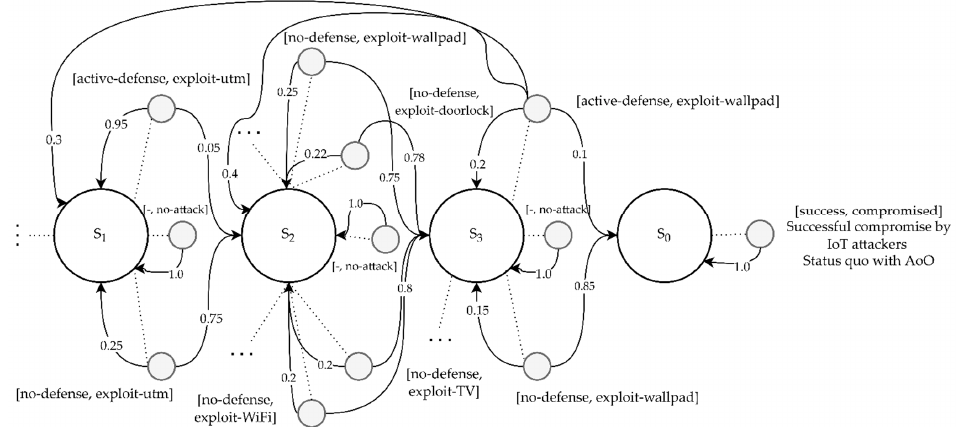
Figure 3. Detailed sub-overview of the POMDP with defender side in IoT-enabled Scenario 1. Table 2. Probability matrix of transition and semi-constant reward value with payoff strategy in IoT-enabled Scenario 1. State